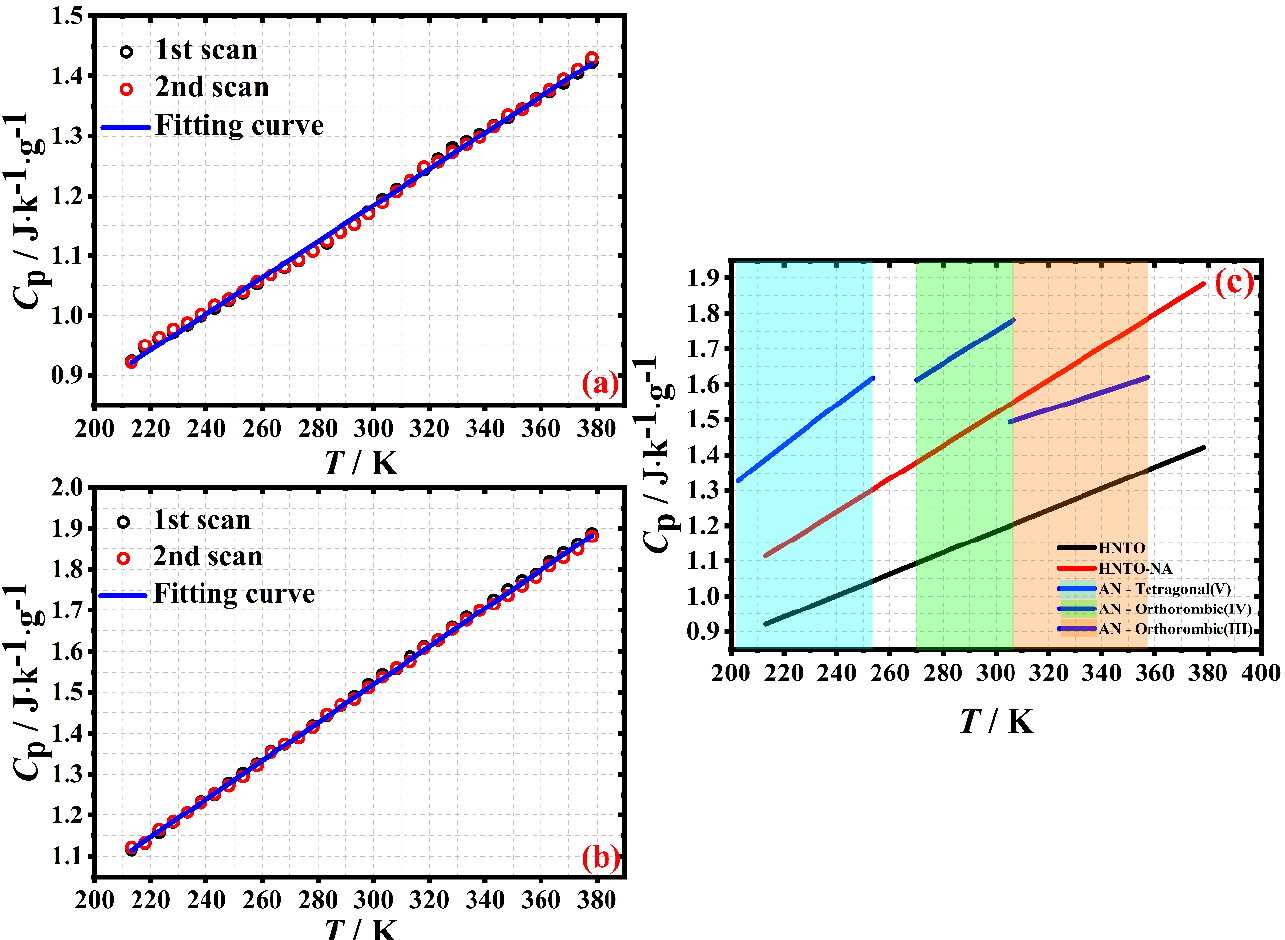
Figure 2. ( a ) Plot of the experimental and fitted heat capacities of HNTO as a function of temperature. ( b ) Plot of the experimental and fitted heat capacities of HNTO·AN cocrystal as a function of temperature. ( c ) Comparison between the fitted heat capacities of AN from [44], HNTO, and HNTO·AN cocrystal.